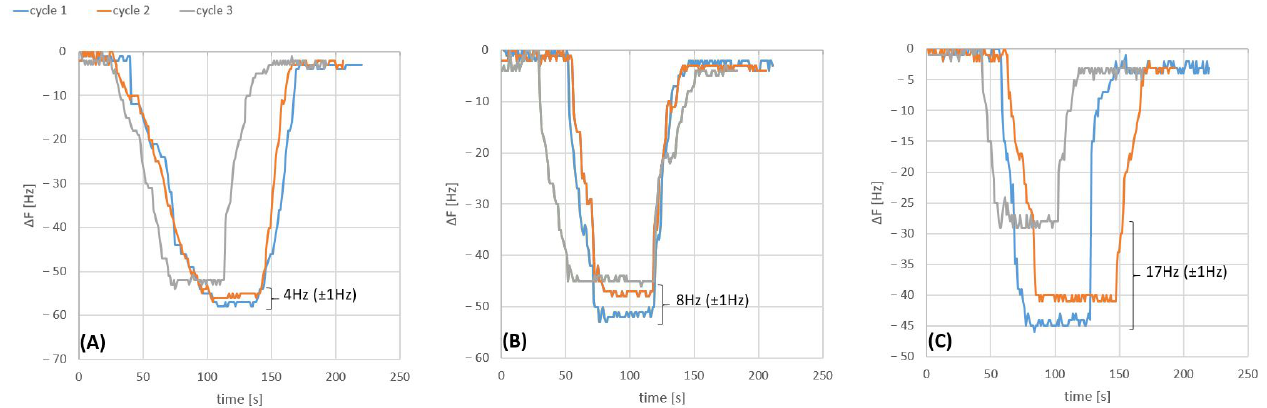
Figure 6. Resonant frequency responses of OBPP-4 based biosensors for nonanal in 65 ppm concentration. Measurements were performed after 3 cycles of cleaning with different methods: ( A ) electrochemical (potassium hydroxide potential sweep, sensor no. D3), ( B ) plasma (sensor no. B2), ( C ) Piranha (sensor no.